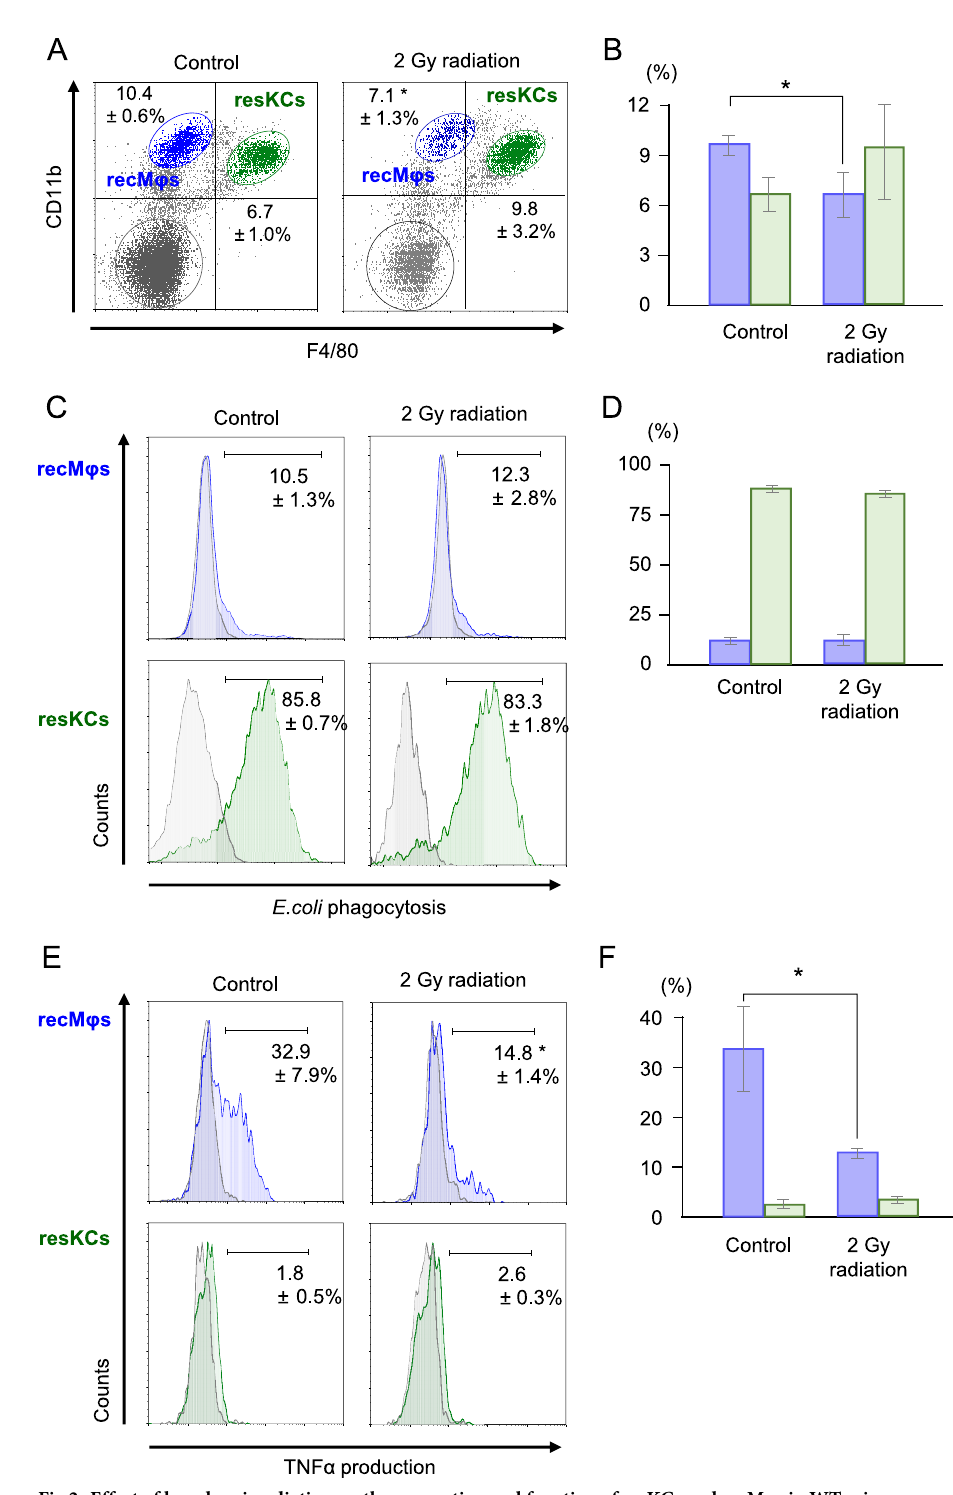
Fig 2. Effect of low-dose irradiation on the proportion and function of resKCs and recM φ s in WT mice. Irradiation-induced changes in the proportion and functions of resKCs and recM φ s. Liver MNCs harvested from normal mice and mice 2 days after irradiation (2 Gy) were analyzed. (A) FACS analysis of F4/80 and CD11b in liver MNCs isolated from control and irradiated mice, with recM φ s and resKCs displayed as blue and green dots, respectively. (B) Bar graph of recM φ (blue columns) and resKC (green columns) abundance in control and irradiated